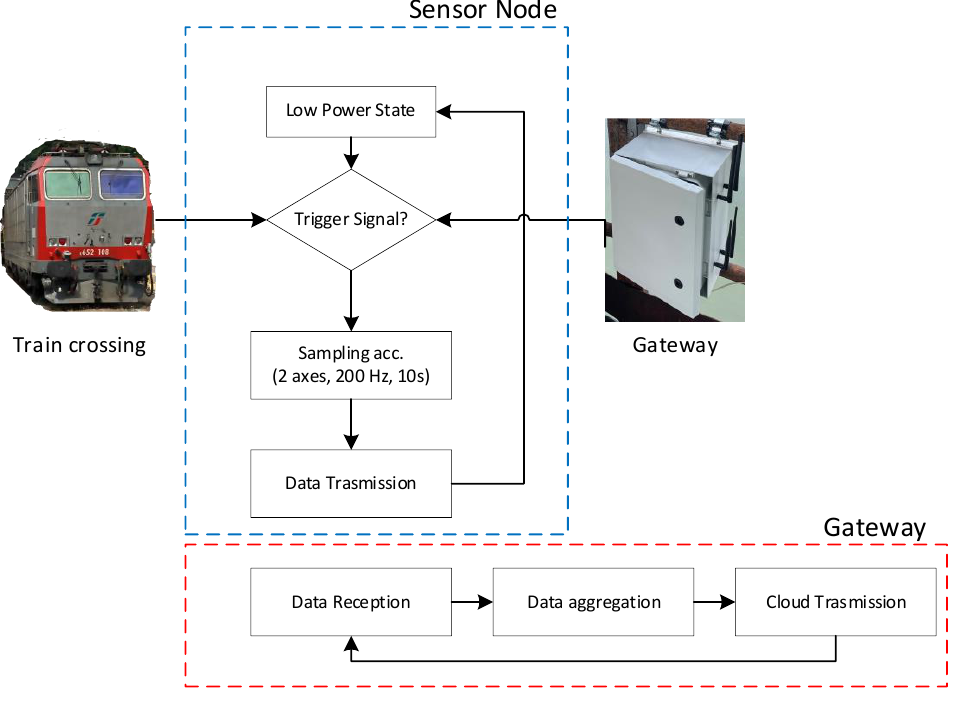
Figure 3. Schematization of the acquisition procedure.